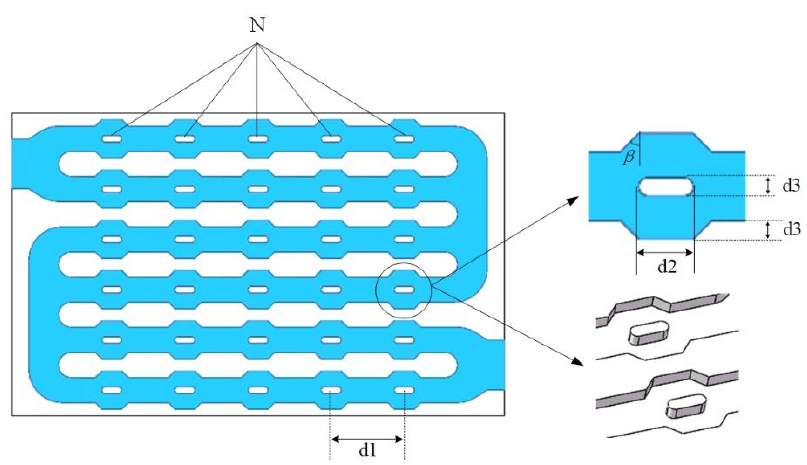
Figure 4. Design of the disturbance structure.